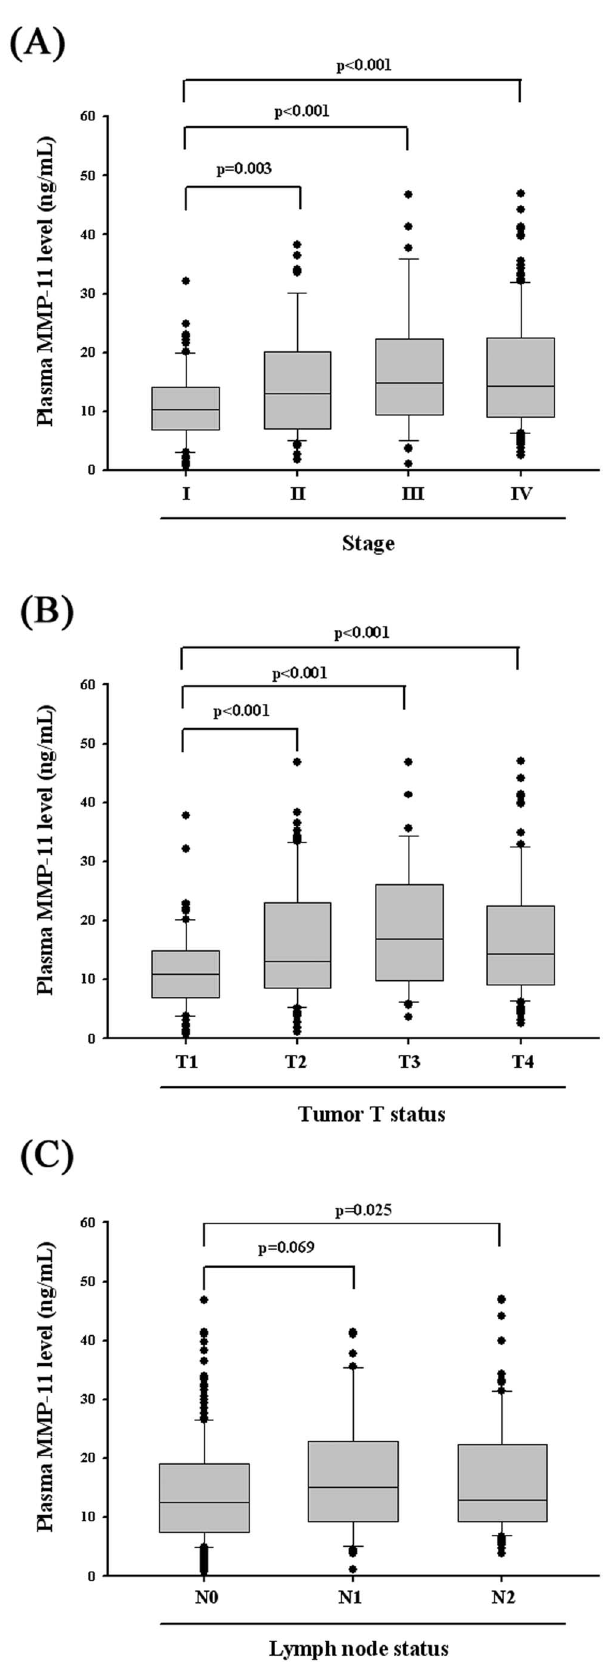
Figure 1. ELISA-determined plasma MMP-11 level of OSCC patients at various clinical features. (A) MMP-11 levels were compared according to stage and results showed that MMP-11 levels were significantly higher in tumor stage II, III and IV when compared with stage I patients. (B) MMP-11 levels were compared according to tumor T status and results showed that MMP-11 levels were significantly higher in advanced tumor extent when compared with T1 patients. (C) MMP-11 levels were compared according to N status and results showed that MMP-11 levels were significantly higher in N2, but not in N1 when compared with patients without nodal